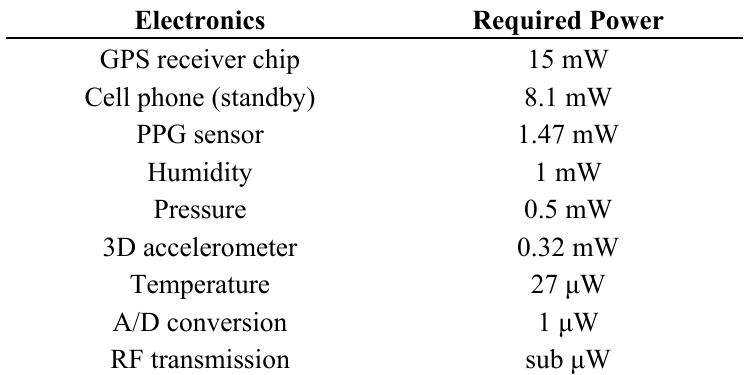
Table 3. Average power consumption of typical electronic devices and